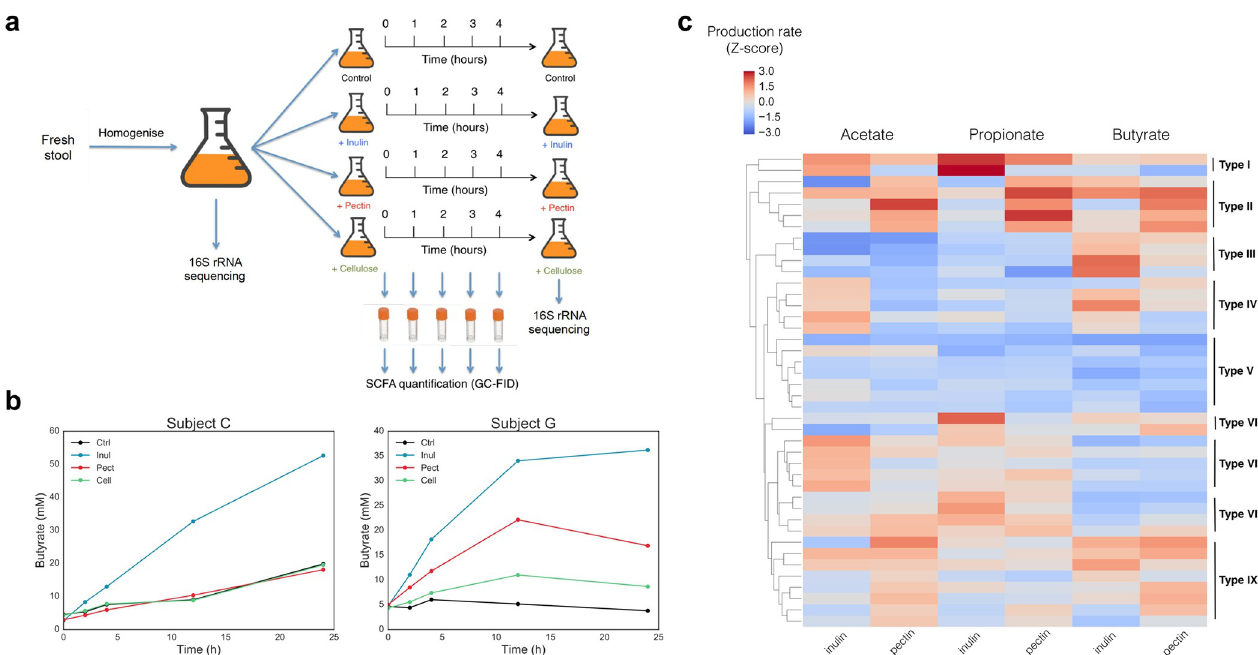
Fig 1. Microbial metabolic phenotype varies significantly in the healthy population. (a) Schematic of assay setup and sampling frequency. (b) 24h time traces of butyrate concentration over time in response to inulin, pectin, cellulose and control, in two different participants. Participant C only produces butyrate from inulin, while participant G produces it from pectin as well. Both participants have linear production regimes in the 0-4h window used to calculate production rate. (c) Acetate, propionate and butyrate production rates from inulin and pectin in different participants, presented as Z-scores computed across all participants. Each row represents measurements from a single sample. SCFA production rates were measured ex vivo in mM/h for each participant in response to each condition. Production rates were computed between timepoints 2h and 4h for each condition and production rates from the control condition (no spike-in) were subtracted. Cellulose timepoints were indistinguishable from control and therefore were not presented.